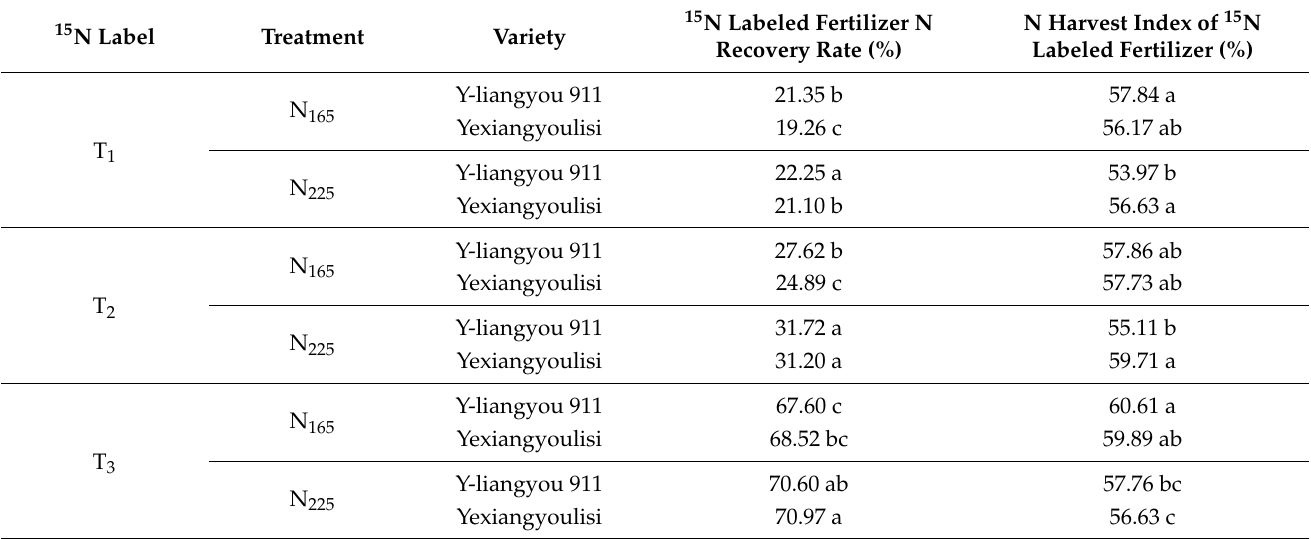
Table 6. Effects of N application rates on N recovery rate and N harvest index of 15 N labeled fertilizer in high-quality rice